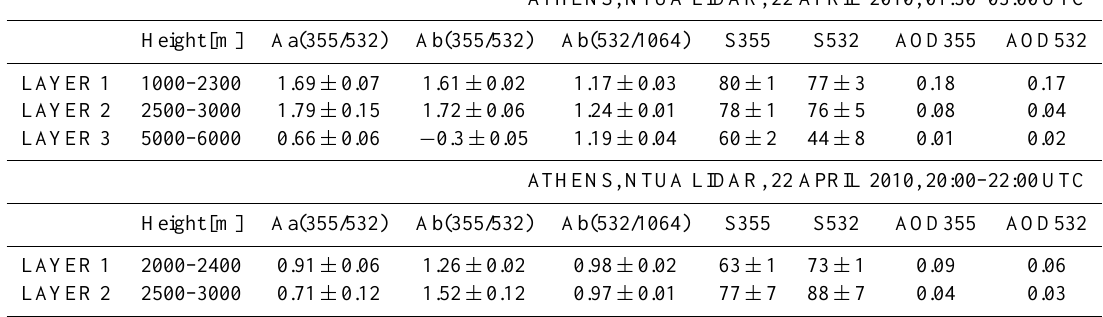
Table 1. Mean values and standard deviations of the aerosol extinction-related Ångström exponent (355nm/532nm), aerosol backscatter- related Ångström exponent (355nm/532nm and 532nm/1064nm), lidar ratio (at 355 and 532nm) and aerosol optical depth at 355 and 532nm obtained by the Raman lidar over Athens, Greece, between 01:30 and 03:00UTC (upper part) and 20:00 and 22:00UTC (lower